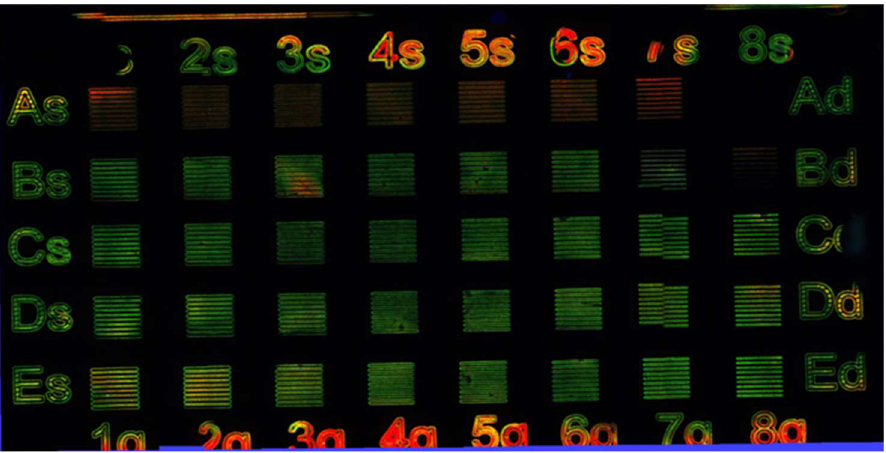
Figure 6. Green search matrix results. The pulse frequency is 20 kHz for all the tested squares with side of 1 mm. The laser parameters and the dose are reported in Table 2.